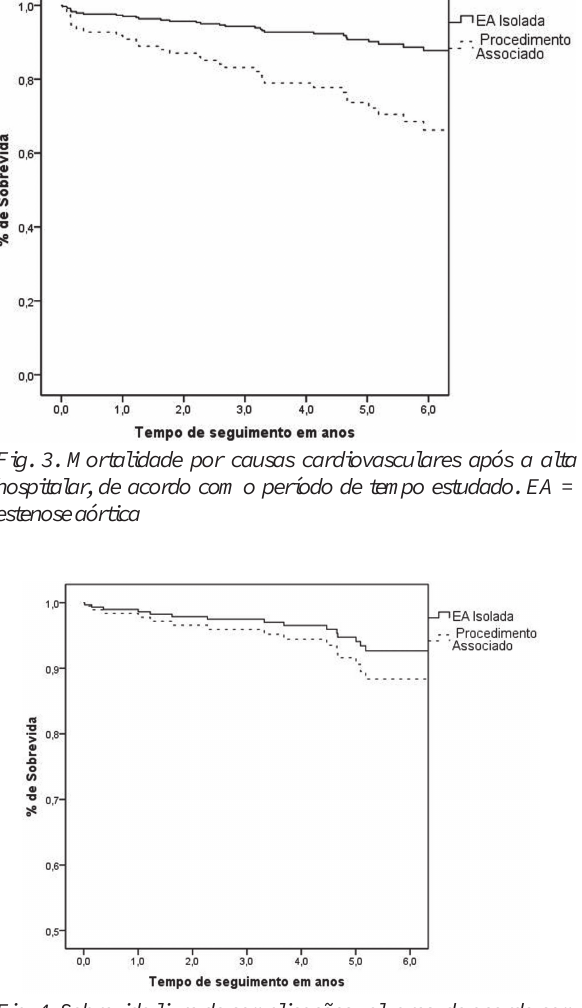
Fig. 4. Sobrevida livre de complicações valvares, de acordo com o período de tempo estudado. EA = estenose